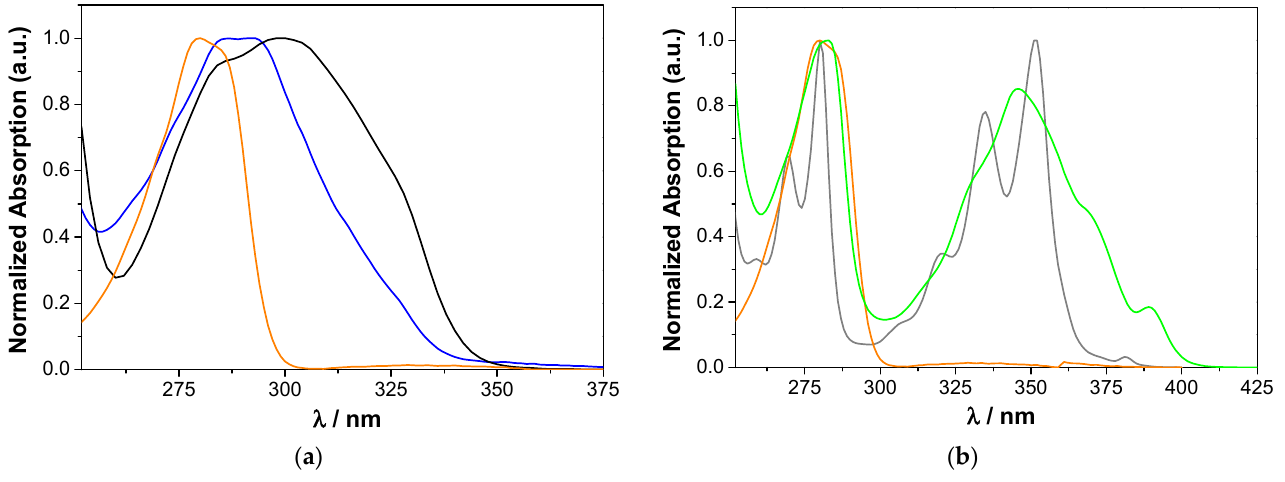
Figure 2. Normalised absorption spectra of ( a ) 1 (orange), A (blue) and 4a (black) and ( b ) 1 (orange), B (grey) and 4c (green) in CH 2 Cl 2 at 25 °C. [ 1 ] = [ A ] = 5 × 10 − 5 M, [ 4a ] = 2 × 10 − 5 M; [ B ] = 4 × 10 − 5 M, [ 4c ] = 1 × 10 − 5